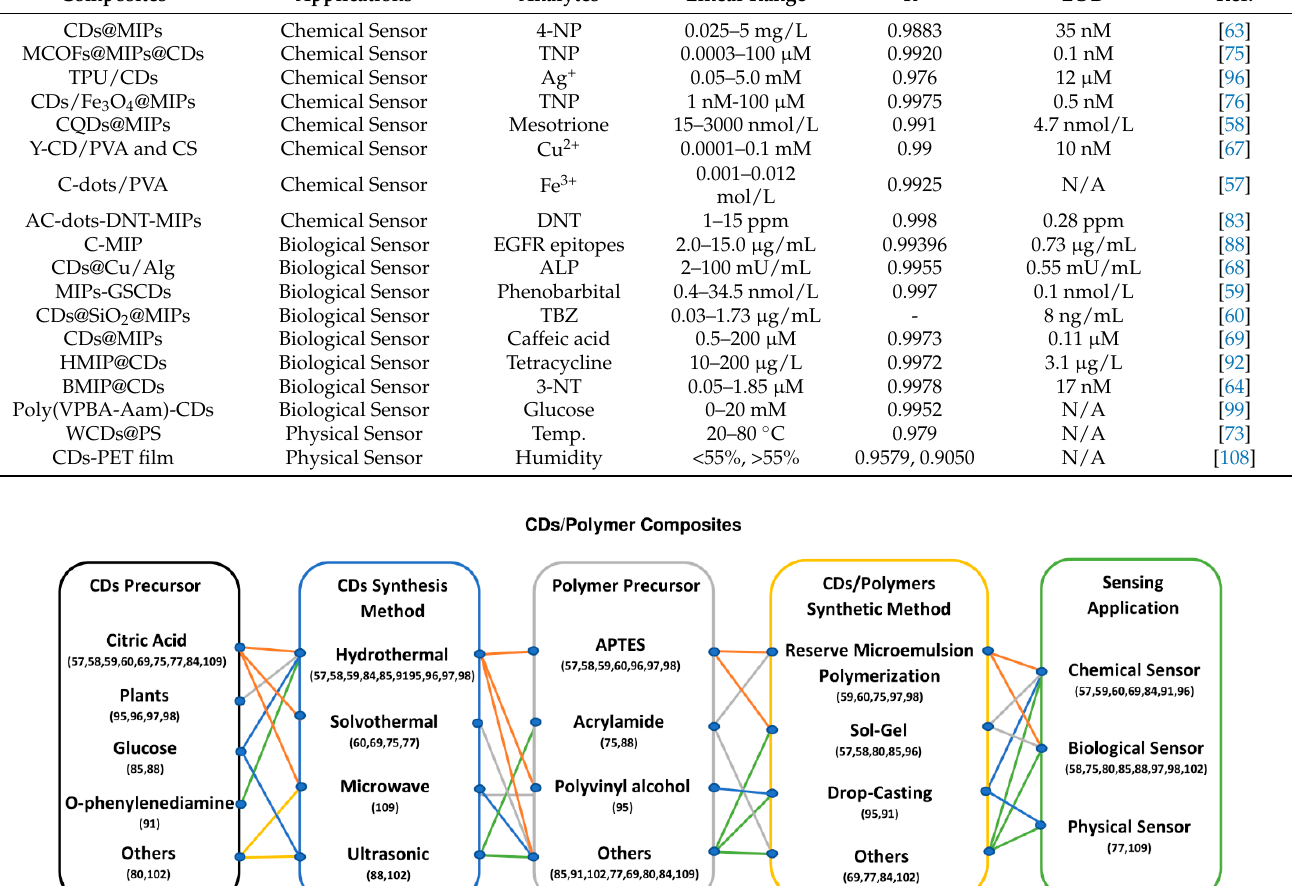
Table 4. Several sensing applications of CD/polymer composites and their sensing performances.